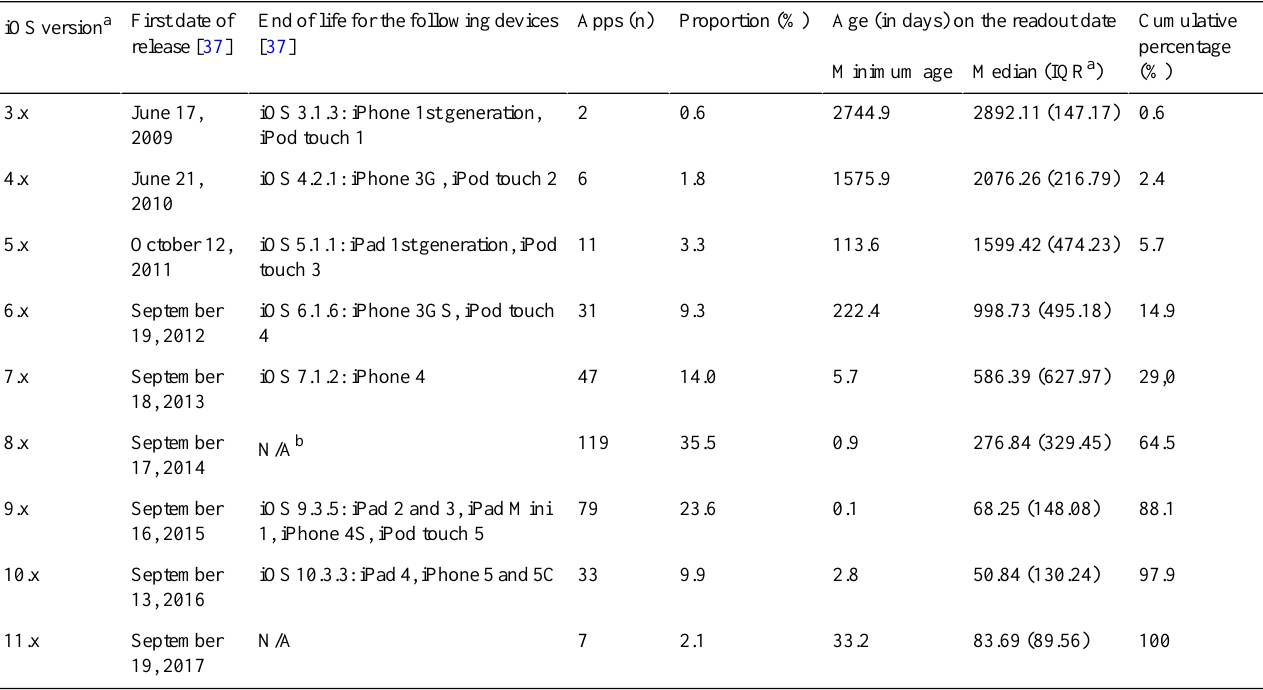
Table 7. Description of the 335 cardiology-related apps stratified by their minimally required iOS versions.